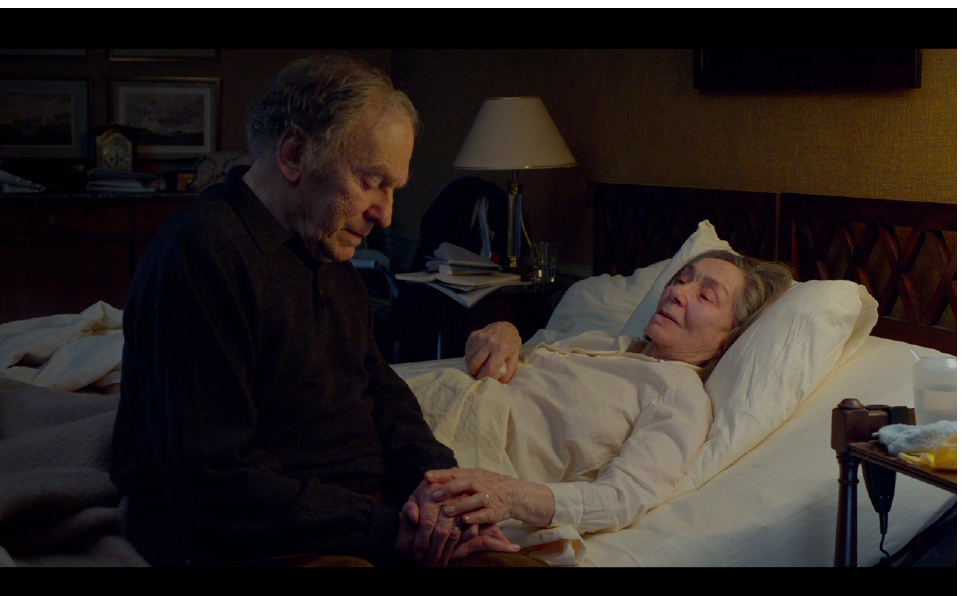
Figure 3. Georges and Anne anticipate her death.